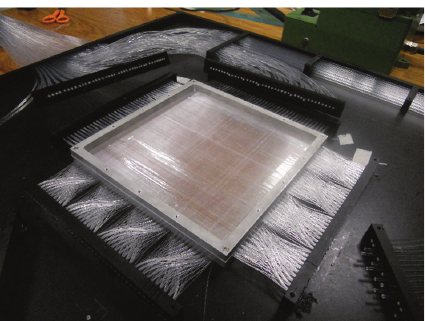
Figure 1: The OFFSET tracker without the cover. The 20 × 20 cm 2